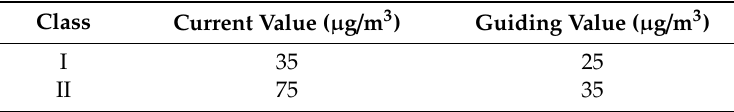
Table 2. Indoor calculated concentration of PM2.5, in